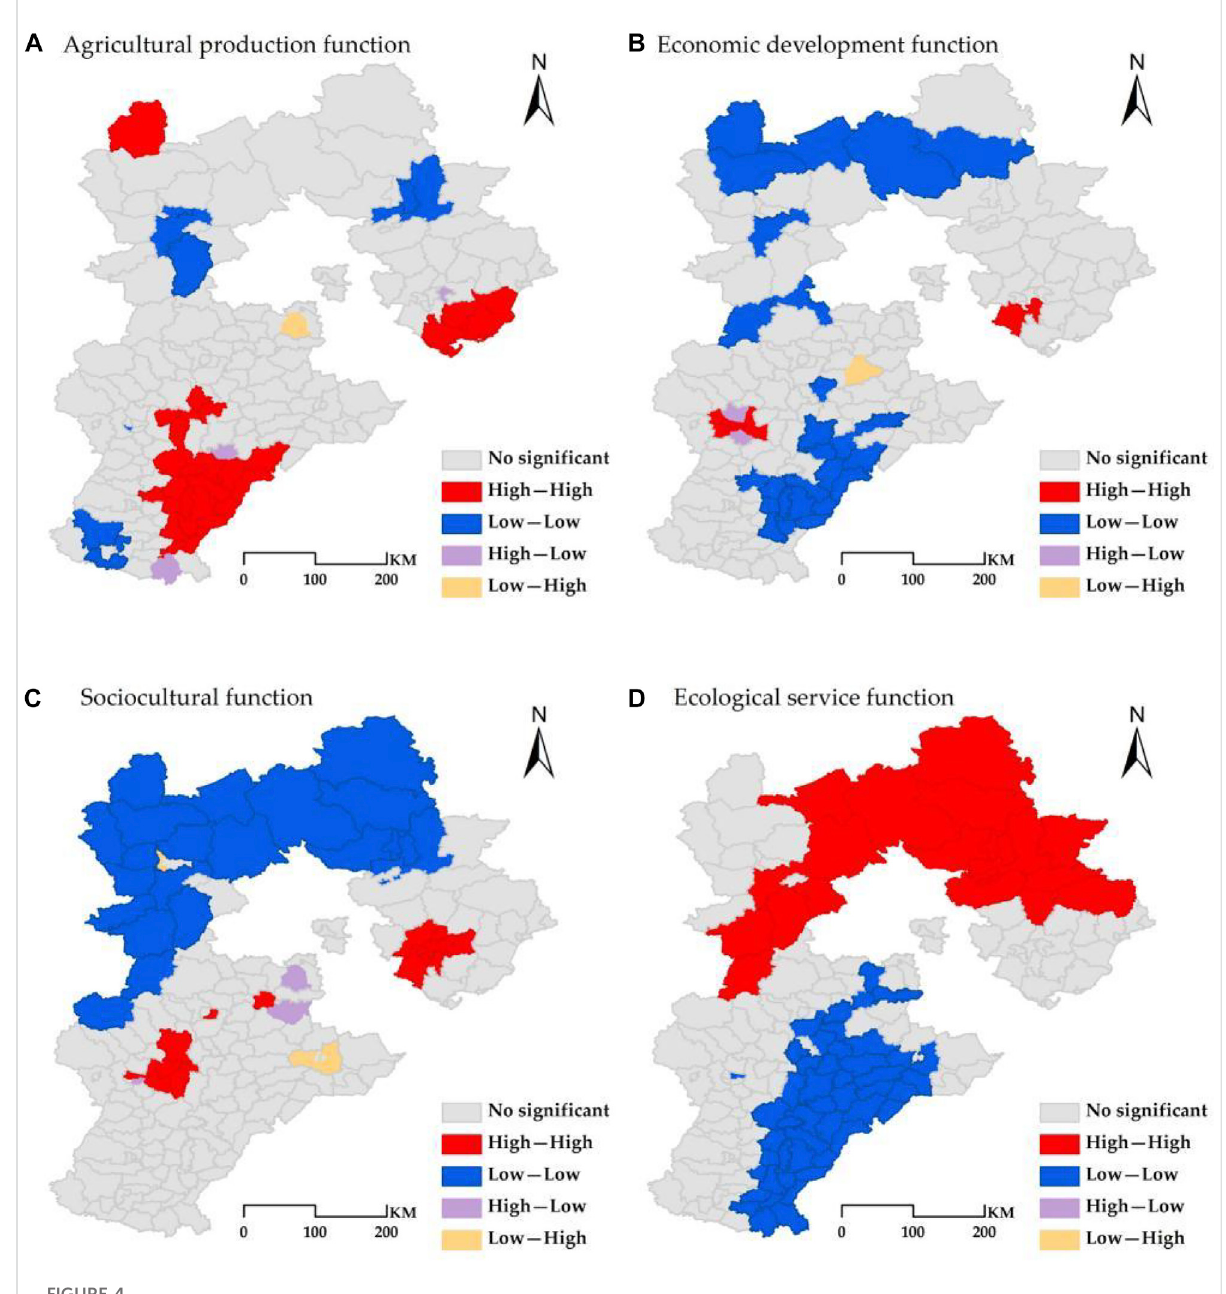
FIGURE 4 LISA map of rural-area multi-functionality of Hebei